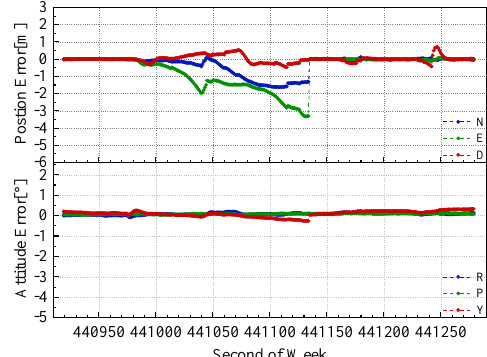
Figure 14. Position and attitude errors of the GNSS / INS / LiDAR-SLAM integrated navigation system in the urban area test.